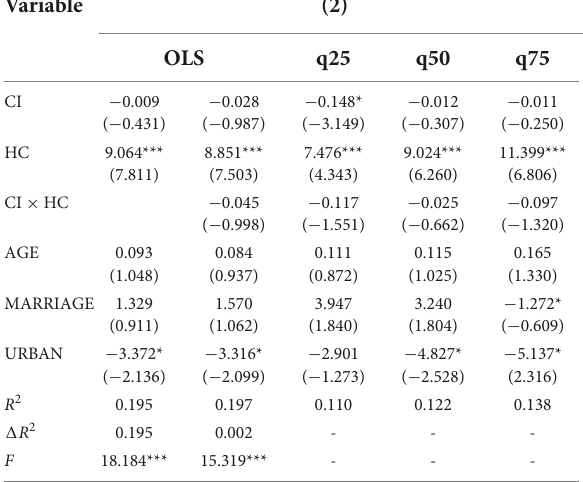
TABLE 5 Analysis of the moderating impact of human